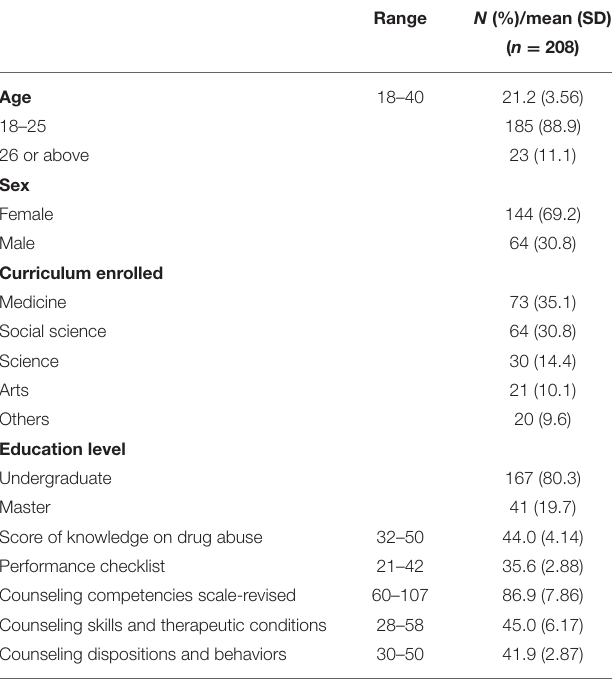
TABLE 1 | Participants’ demographic information and counseling skill performance.